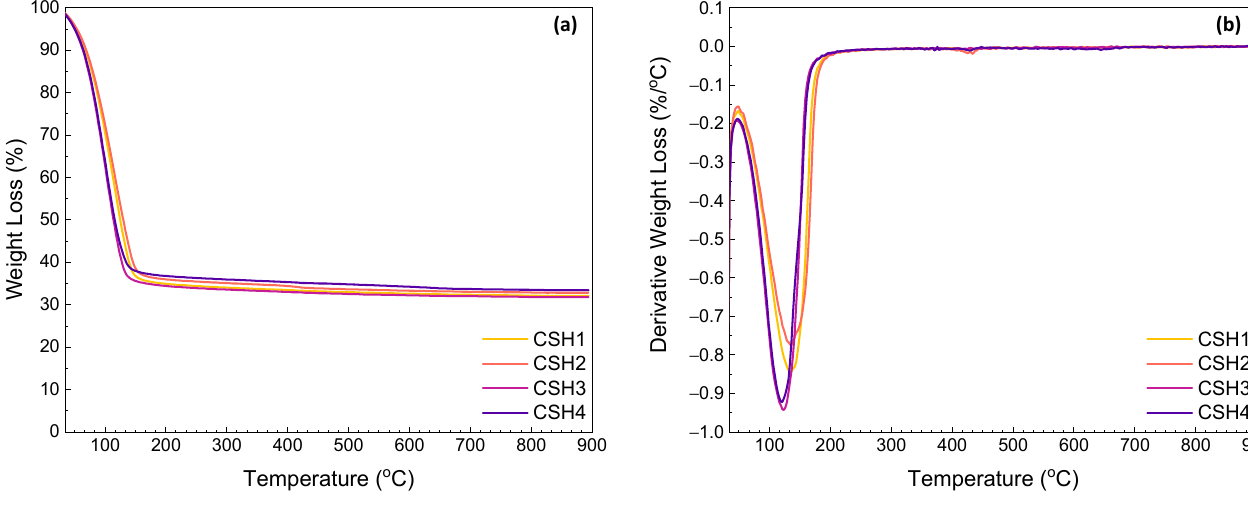
Figure 6. TGA ( a ) and DTG ( b ) curves for CSH gels at day 14. The second and the third weight losses that occurred in the ranges 350–500 °C and 550–893 °C are attributed to the dehydroxylation of portlandite (CH) and the decomposition of calcium carbonate due to carbonation of the CH, respectively. According to [48], three modes of calcium carbonate, which can coexist in the ultimate carbonation state of hydrated cement, can be identified from the differential TG (DTG) traces of calcium carbonate decomposition. The decomposition of well-crystallized calcite in the range of 780–990 °C could define Mode I. Mode II is explained by the decomposition of carbonates by aragonite and vaterite at a lower temperature range of 700–780 °C. Finally, the range of 550–700 °C is related to the decomposition of amorphous calcium carbonate as Mode III. It was reported that the neat PAAm usually decomposes in multiple temperature ranges from 30 to 650 °C, where the maximum weight loss (44.6%) occurs at about 540 °C [49,50], which overlaps the thermal decomposition of calcium carbonate. The slight weight losses of the TGA and the corresponding shoulders of the